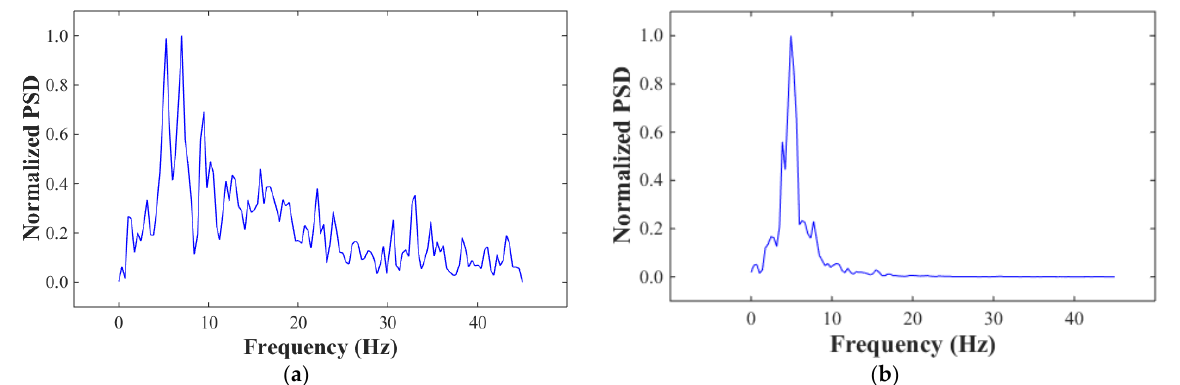
Figure 9. Power spectral density before and after mitigation of optical turbulence errors: ( a ) Before mitigation; ( b ) After mitigation.